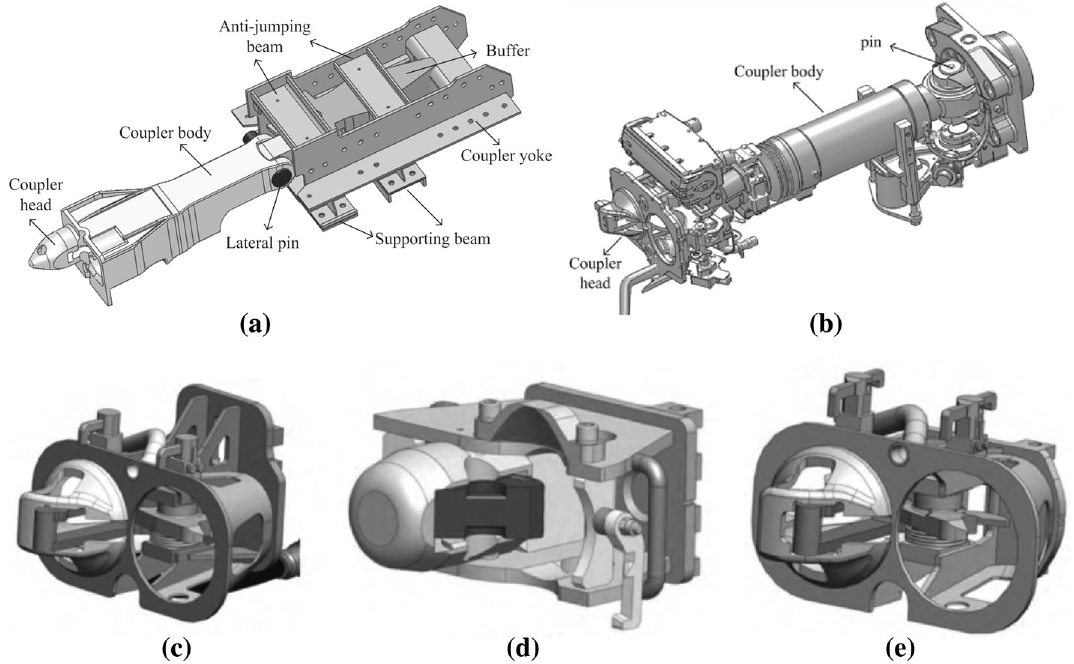
Fig. 1 Typical coupler and draft gear structures of domestic EMUs. a Shibata coupler. b Type 10 coupler. c Transition coupler module 1. d Transition coupler module 2. e Transition coupler module